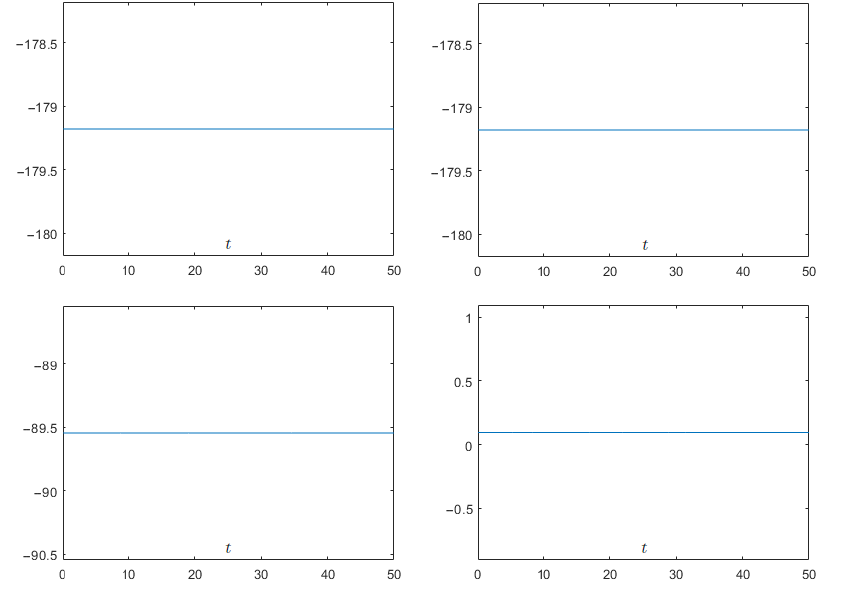
(cid:107) 2 computed by the numerical t